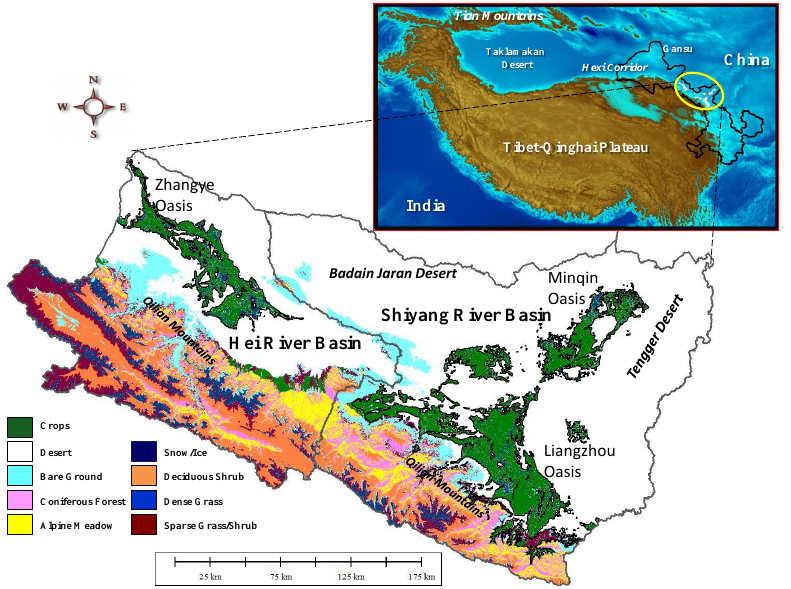
Figure 1. The Shiyang and Hei river basins with distribution of dominant land cover classes, classified with a decision-tree classifier and categorisation thresholds summarised in Table A1 (Appendix). The inset shows the location of the study area along the north-eastern flank of the Qinghai–Tibet